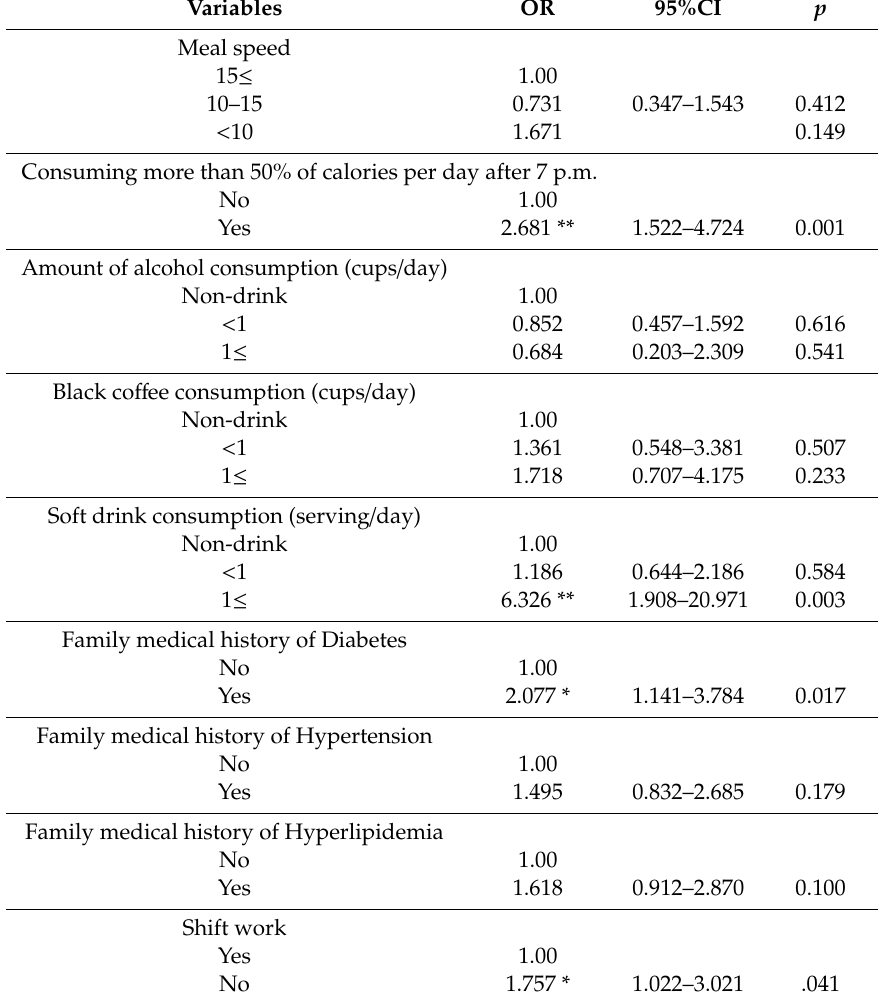
Table 4. Result of the multivariate logistic regression